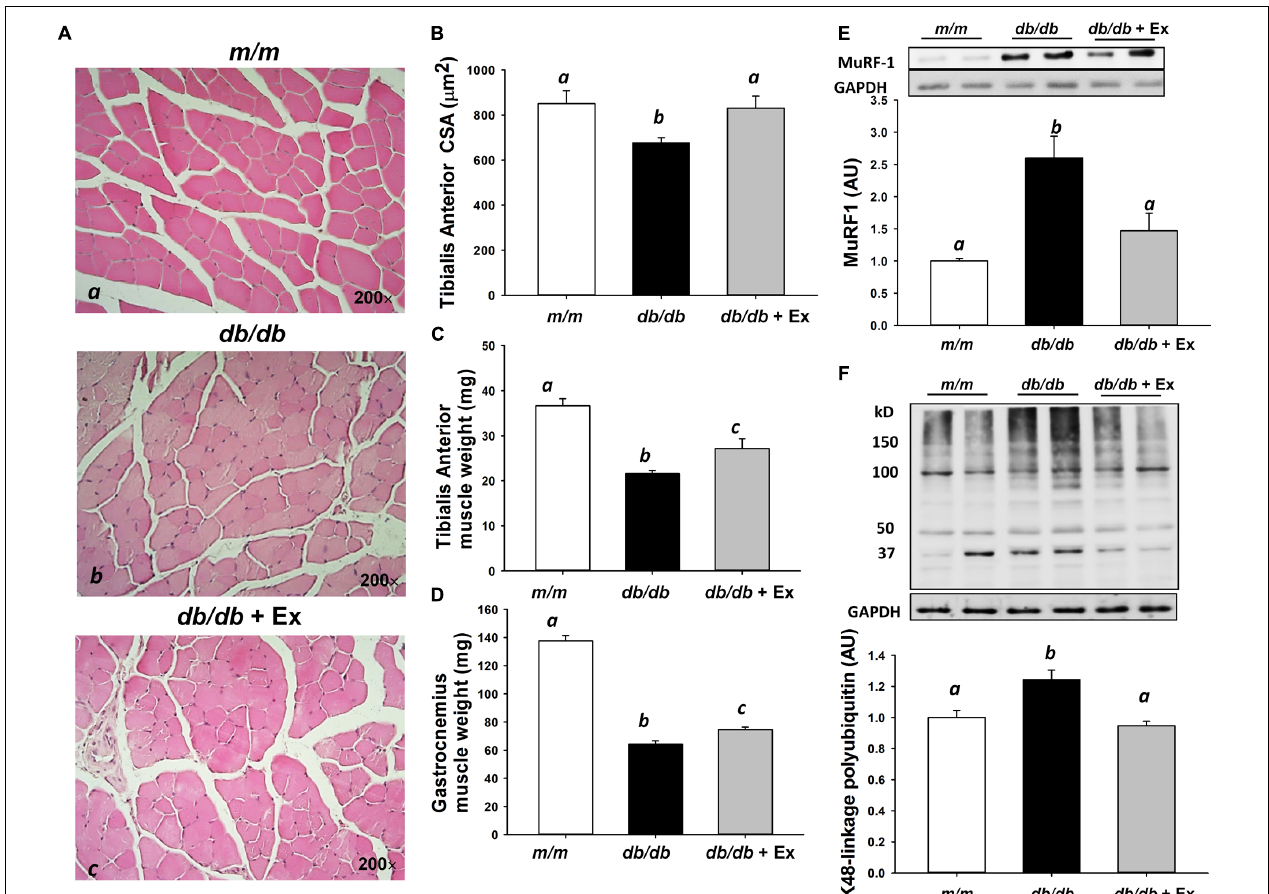
FIGURE 2 | Effect of moderate exercise training on muscle size, muscle weight, and protein expression. Representative hematoxylin-eosin stained of tibialis anterior muscle (Aa–c) in m/m , db/db , and d b/db +Ex groups (200 × ). Mean cross-sectional area of tibialis anterior muscle ( B , n = 4/group). Tibialis anterior (C) and gastrocnemius (D) muscle weight ( n = 9–12/group). Representative blots of MuRF-1 and K48-linkage polyubiquitin ( E,F , n = 5–8). Values presented are mean ± SEM. Significance ( P < 0.05) among groups is denoted by different letters.